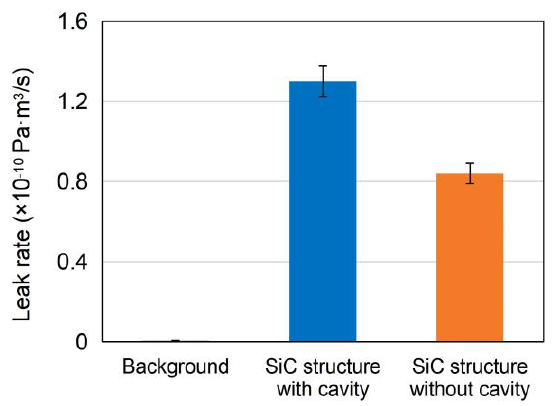
Figure 10. Measured leak rates of fine leak detection.